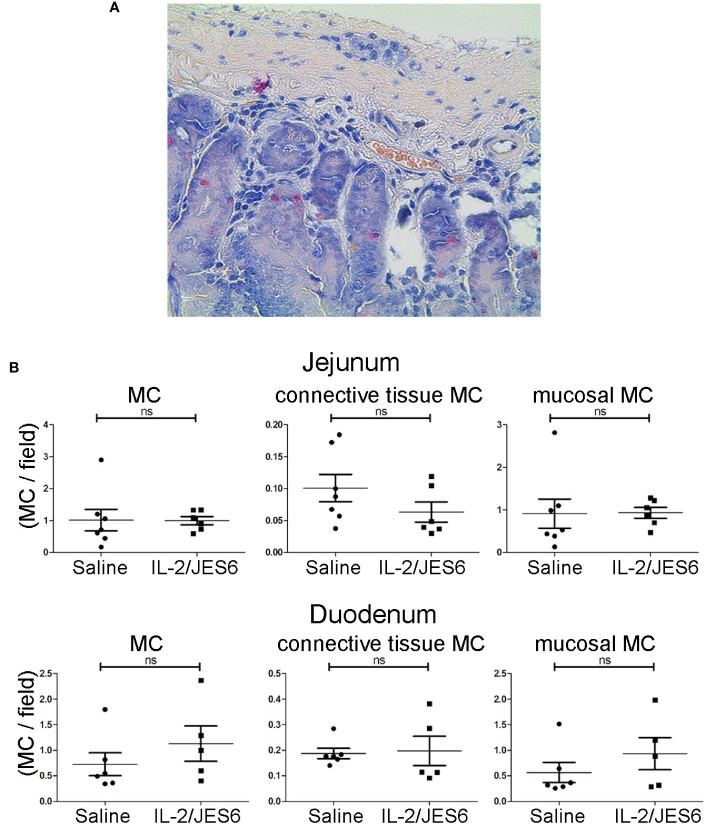
Mast cell populations in the gut. Gut sections from sensitized mice treated with IL-2/JES6 or PBS for three days prior to sensitization. Mast cells were identified by chloroacetate esterase (CAE) staining. (A) Representative section of duodenum, 40x magnification. (B) All mast cells, connective tissue mast cells and mucosal mast cells in jejunum (upper row) and duodenum (lower row) are shown, as indicated. Plots show mast cells per field of view (MC/field). Upper row: jejunum, lower row: duodenum, as indicated. Each dot represents the average mast cell counts from one individual mouse, two to six slices were counted per mouse (n = 5; Mann-Whitney U test). ns, not significant.